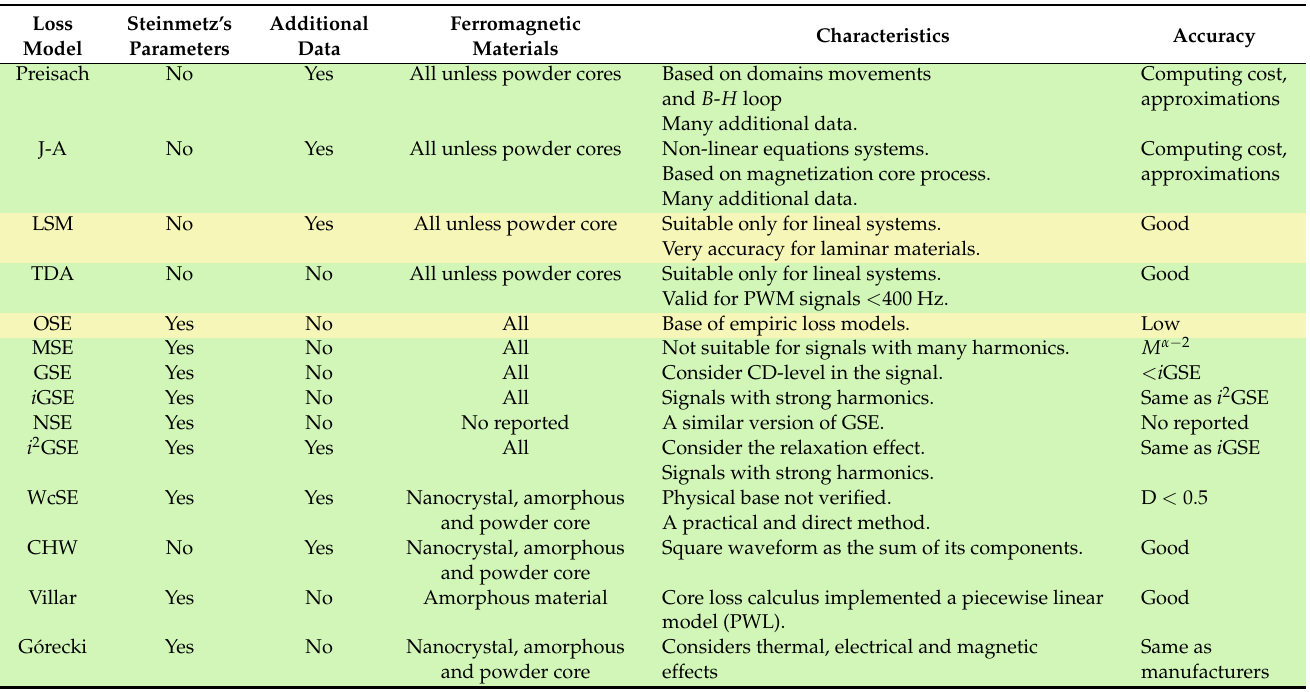
Table 3. Comparison between empiric core losses models. The sinusoidal and non-sinusoidal waveform are indicated with light yellow and light green,